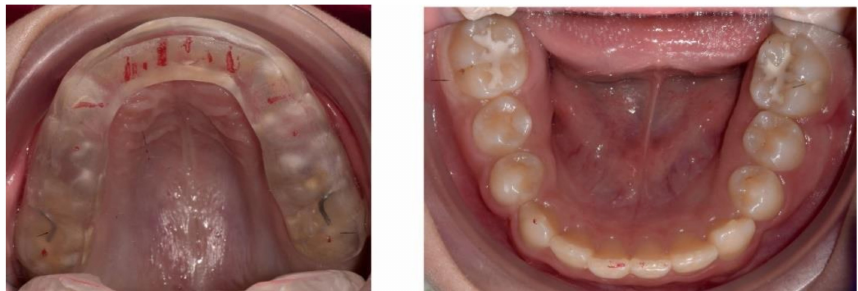
Figure 11. Intra-oral occlusal photographs with maxillary